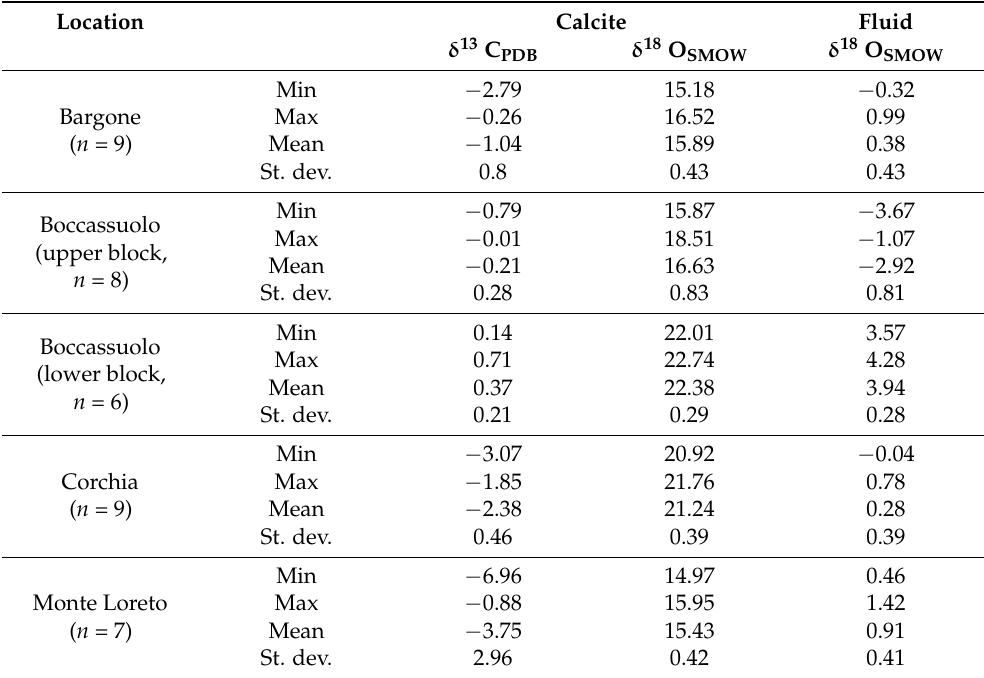
Table 4. Results of the H isotope geochemical analyses of quartz-hosted fluid inclusions. Bargone, quartz Boccassuolo (upper block), quartz − 41.15 Boccassuolo (lower block),